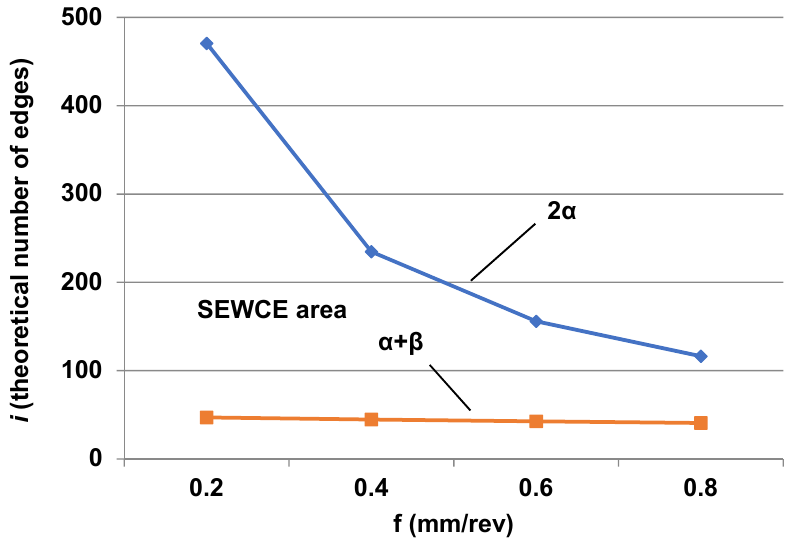
Figure 20. Example of SEWCE area for the developed tool (r ε = 1.5 mm) for z = 10 and a p = 0,4 mm.